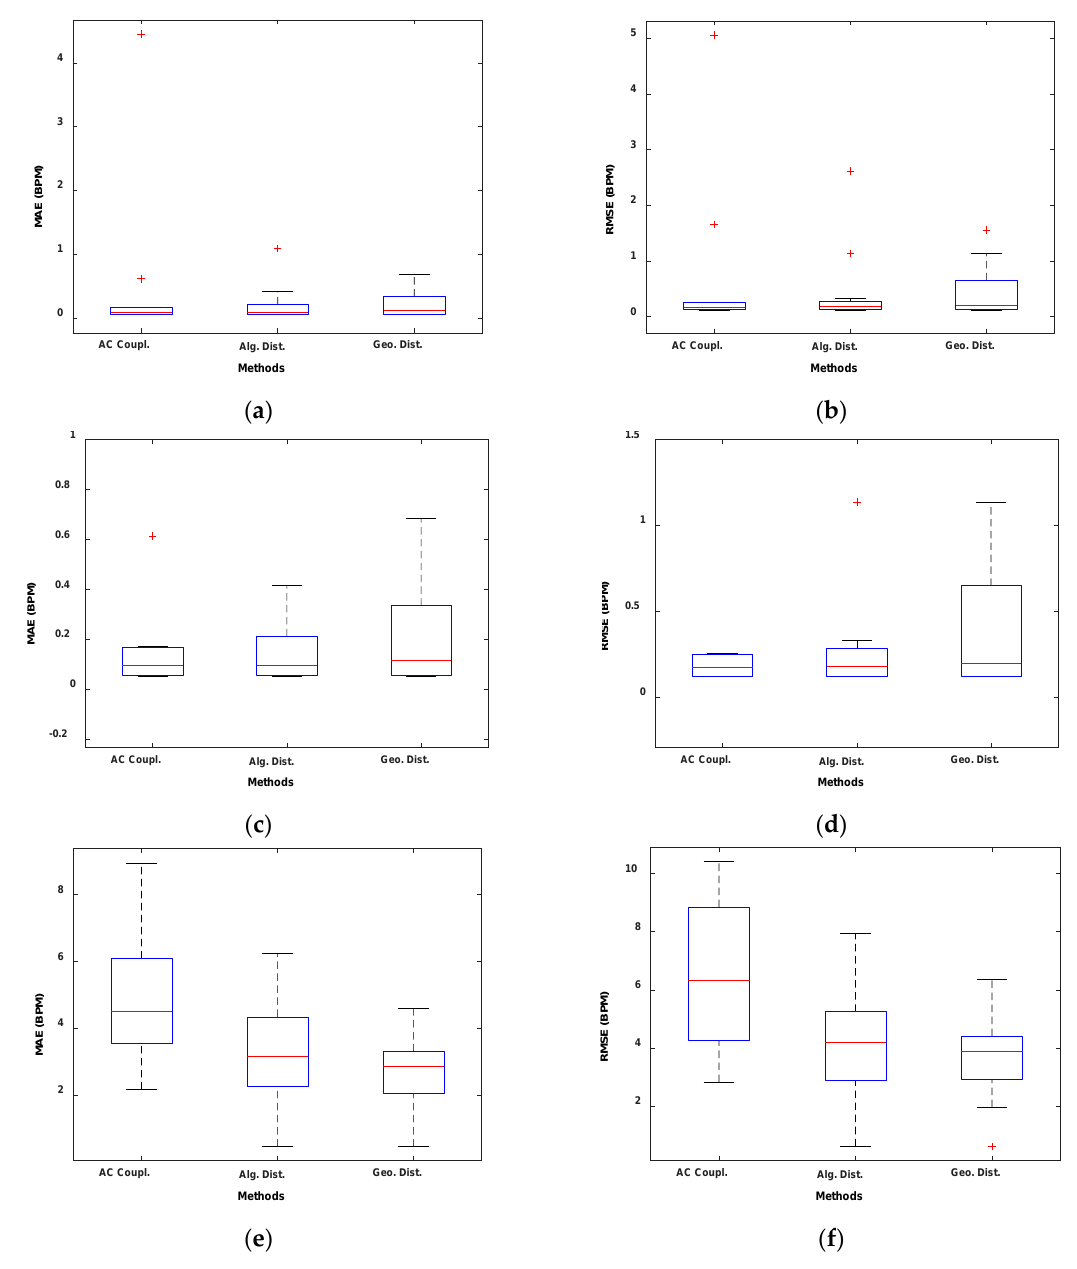
Figure 3. Boxplots of the experimental validation using the mmWave radar. ( a ) MAE RR. ( b ) RMSE RR. ( c ) Zoomed version of ( a ). ( d ) Zoomed version of ( b ). ( e ) MAE HR. ( f ) RMSE HR.